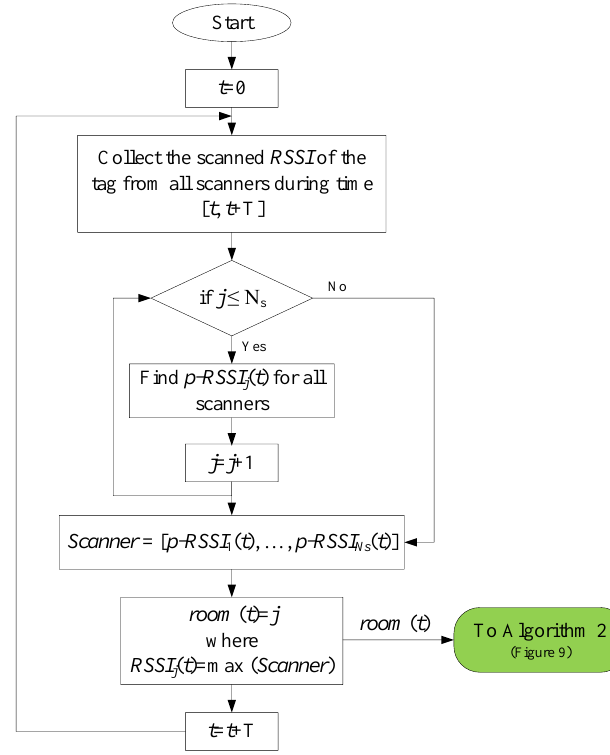
Figure 4. Flowchart of room-level localization in a smart home using raw BLE data (Algorithm 1).